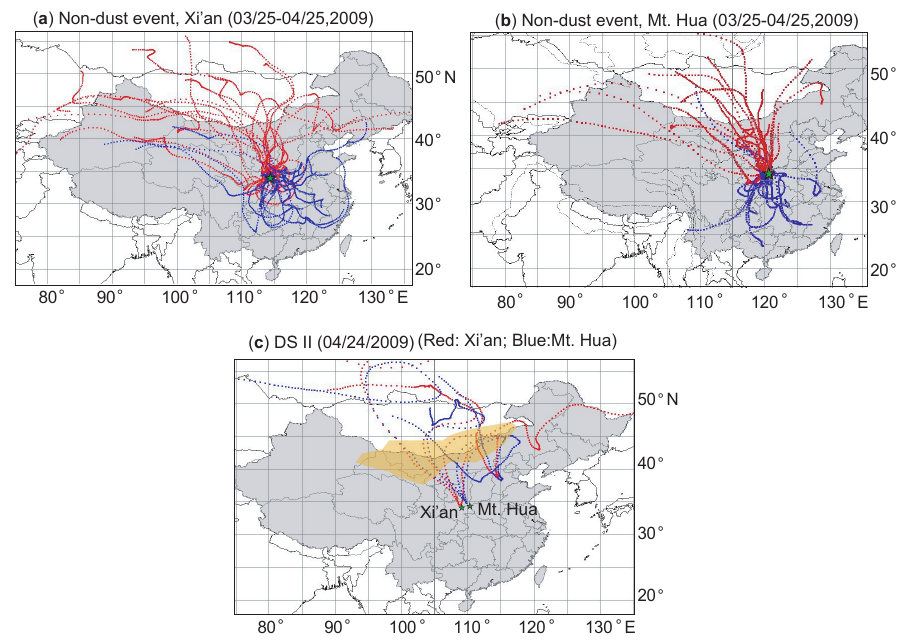
Figure 3. Backward trajectories of air masses reaching Xi’an and Mt. Hua during ( a , b ) the non-dust event (24h interval, air masses transported from northerly are in red while those from southerly are in blue) and ( c ) the dust storm event II (DS II, 0:00-18:00, local time, 6h interval, air massese reaching Xi’an are in red while those reaching Mt. Hua are in blue) (The yellowish shadow in Figure c is the Gobi desert region)